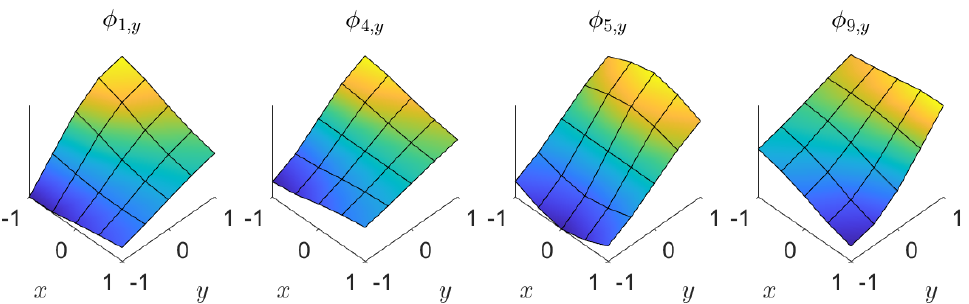
Figure 4. Shape functions of Figure 2 derived with respect to y